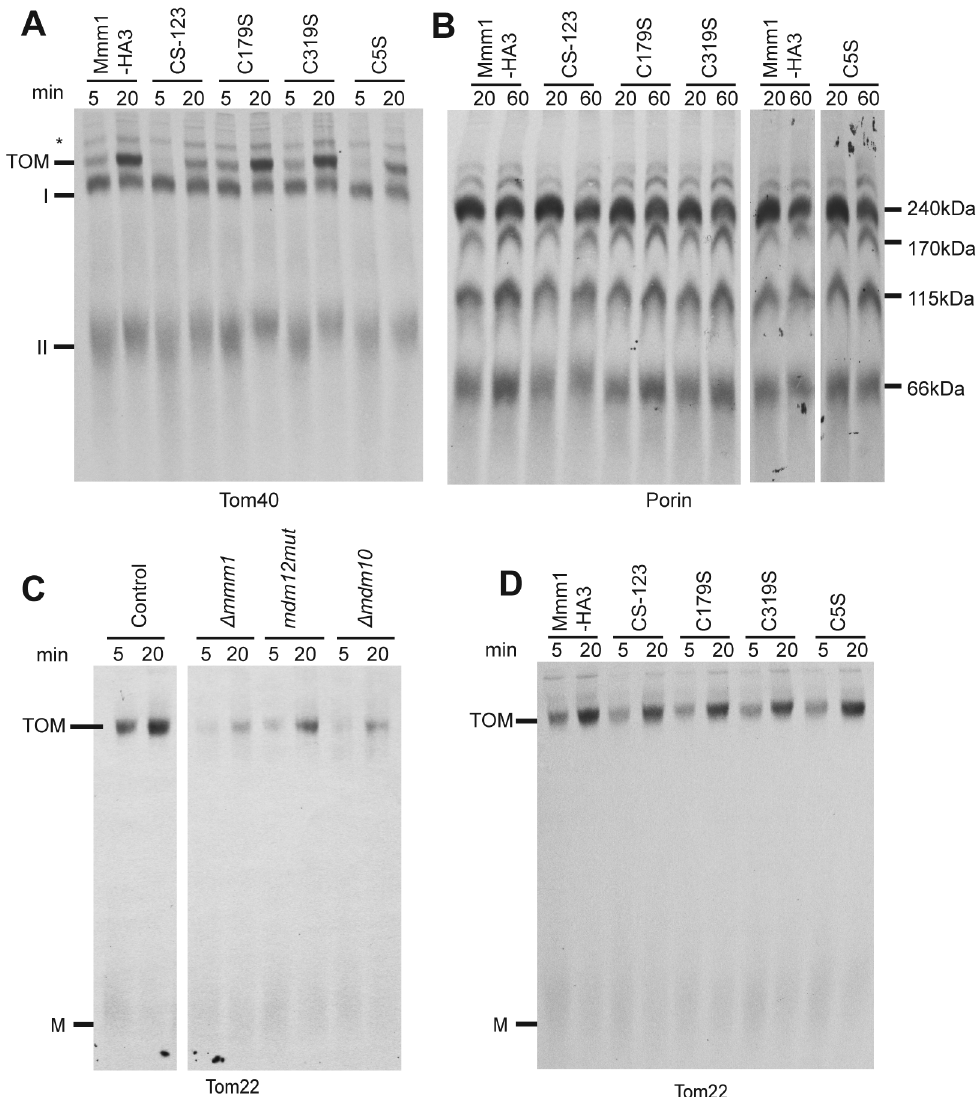
Figure 4. Assembly of mitochondrial outer membrane proteins into Mmm1 Cys to Ser mutants. A. Import and assembly of Tom40 was assayed by incubating radiolabeled Tom40 precursor with isolated mitochondria for the indicated times. After import, the mitochondria were reisolated and dissolved in 1% digitonin. The samples were subjected to BNGE, transferred to PVDF membrane and analyzed by autoradiography. The positions of the mature TOM complex, intermediates I and II, and an unknown band (*) are indicated. The time (min) of each import reaction is indicated above the lanes. B. As in A, except radiolabelled porin precursor was imported. The molecular masses of the major complexes containing radiolabeled porin are indicated. C. As in A, but radiolabeled Tom22 precursor was imported into isolated mitochondria from the indicated strains. Mature TOM complex and monomeric Tom22 (M) are indicated. D. Assembly of Tom22 into mitochondria from the indicated strains as in panel C.